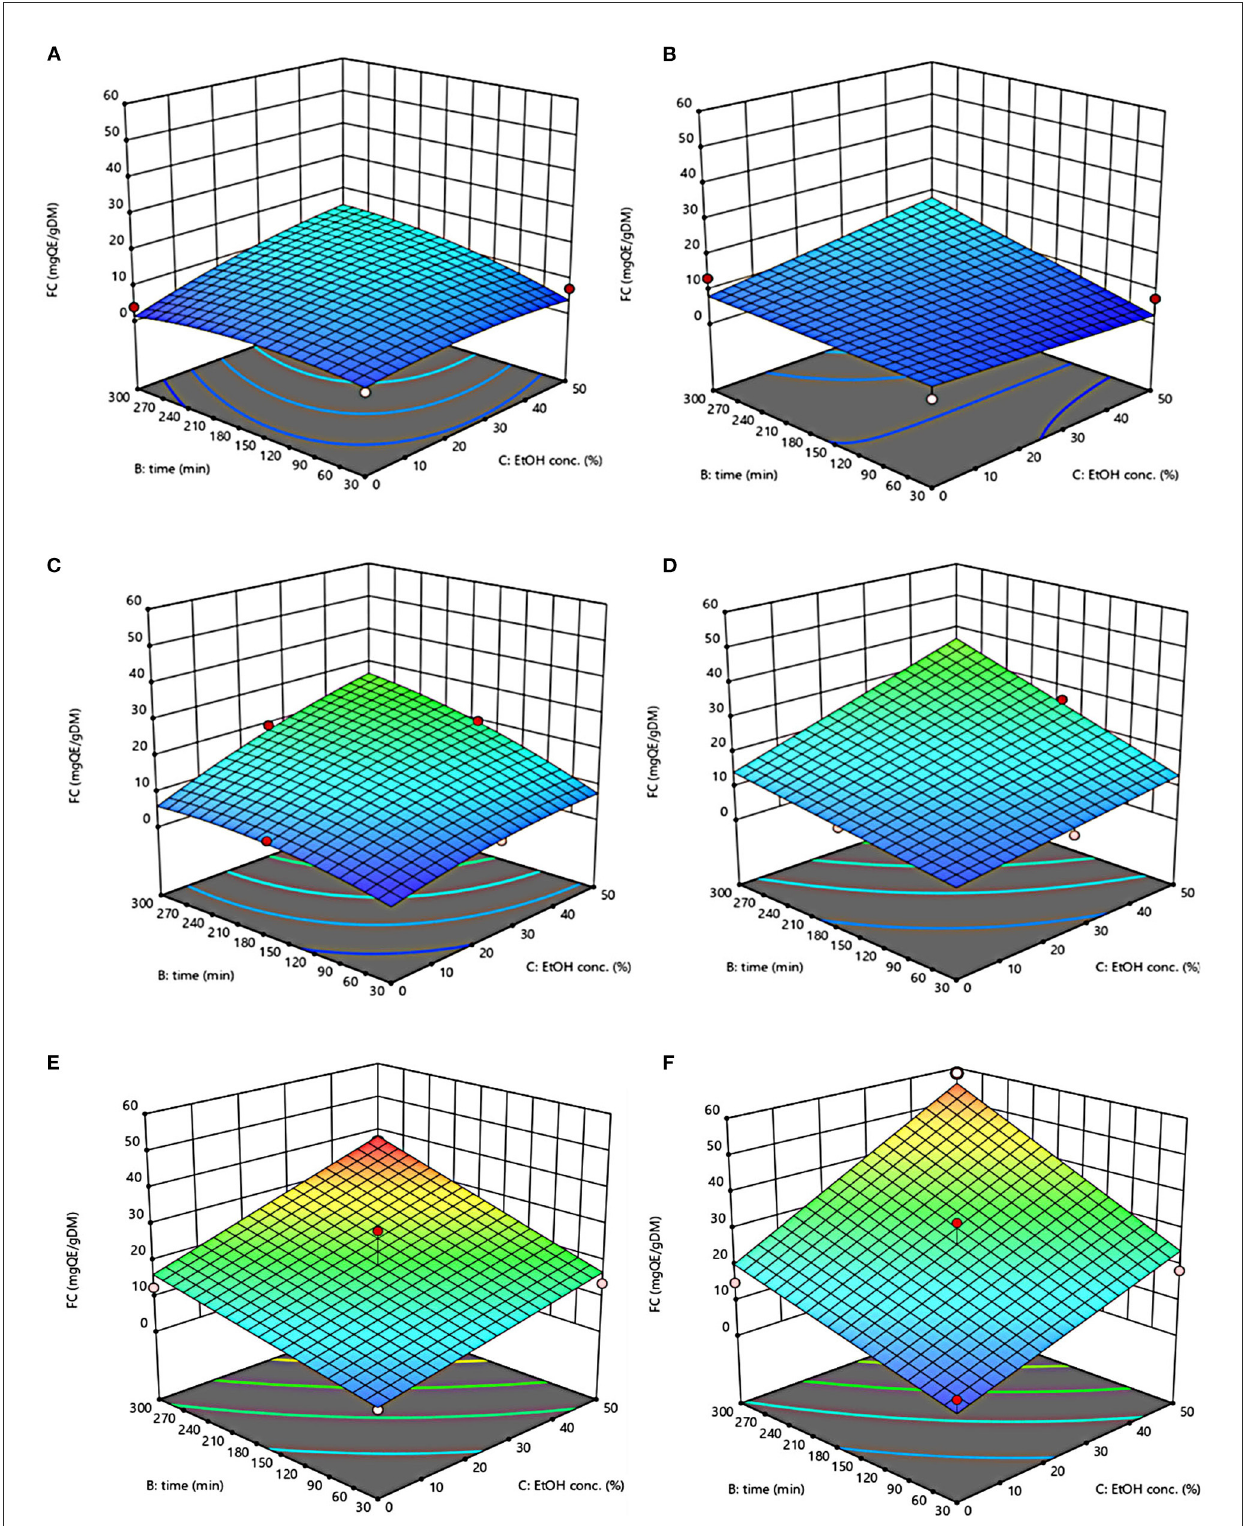
FIGURE3 Response surfaces of Flavonoid Content (FC) of extracts from untreated (Control) (A, C, E) and PEF-treated (E = 4.6 kV/cm; WT = 20kJ/kg) (B, D, F) grape pomace as a function of extraction time and ethanol concentration. Extraction temperature set at 20 ◦ C (A, B) , 35 ◦ C (C, D) , 50 ◦ C (E, F) .